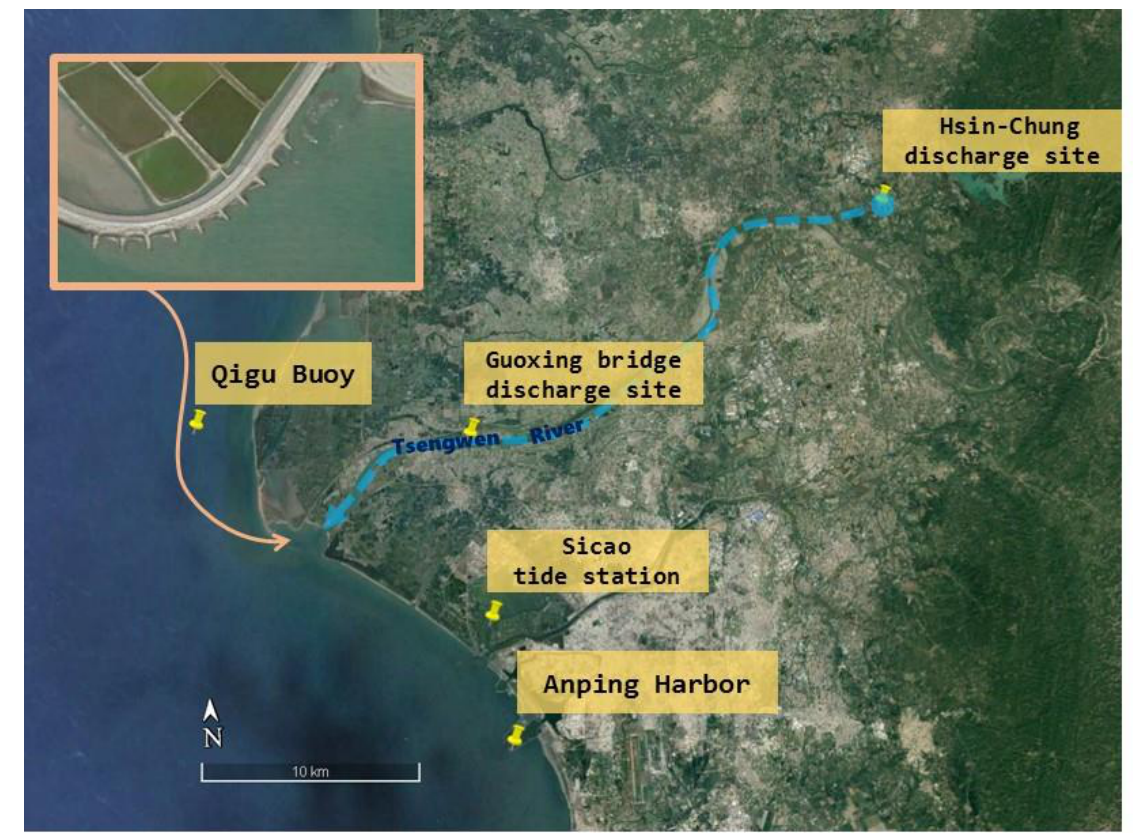
Figure 1. Study Site: the Zengwen River Mouth and the newly constructed groins near the river mouth (background source: google map). The observation in the Hsin-Chung Station is used for the river boundary. The observations in the Anping station and the Qigu Wave Buoy are used for the wave boundary. The Sicao tidal gauge and Guoxing discharge site are used for model